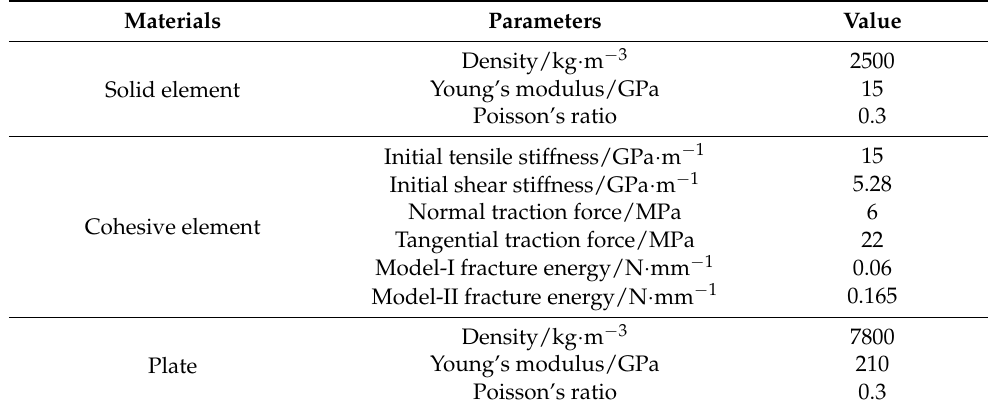
Figure 6. Uniaxial compression test and simulation results. Table 1. Numerical simulation material